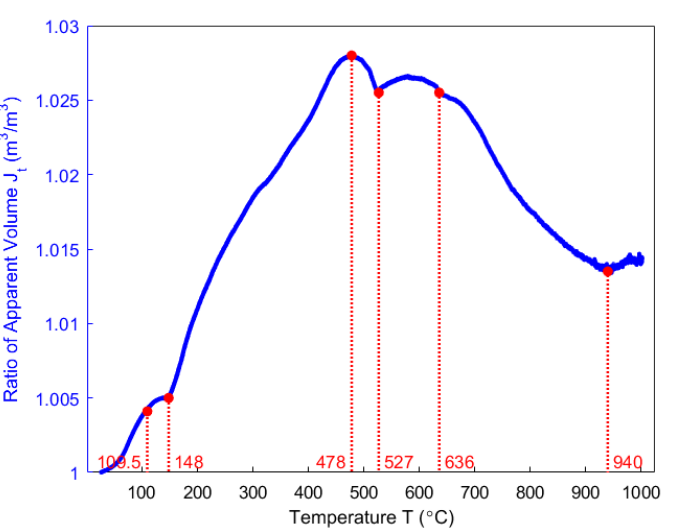
Figure 10. The evolution of the ratio of apparent volume as a function of temperature.